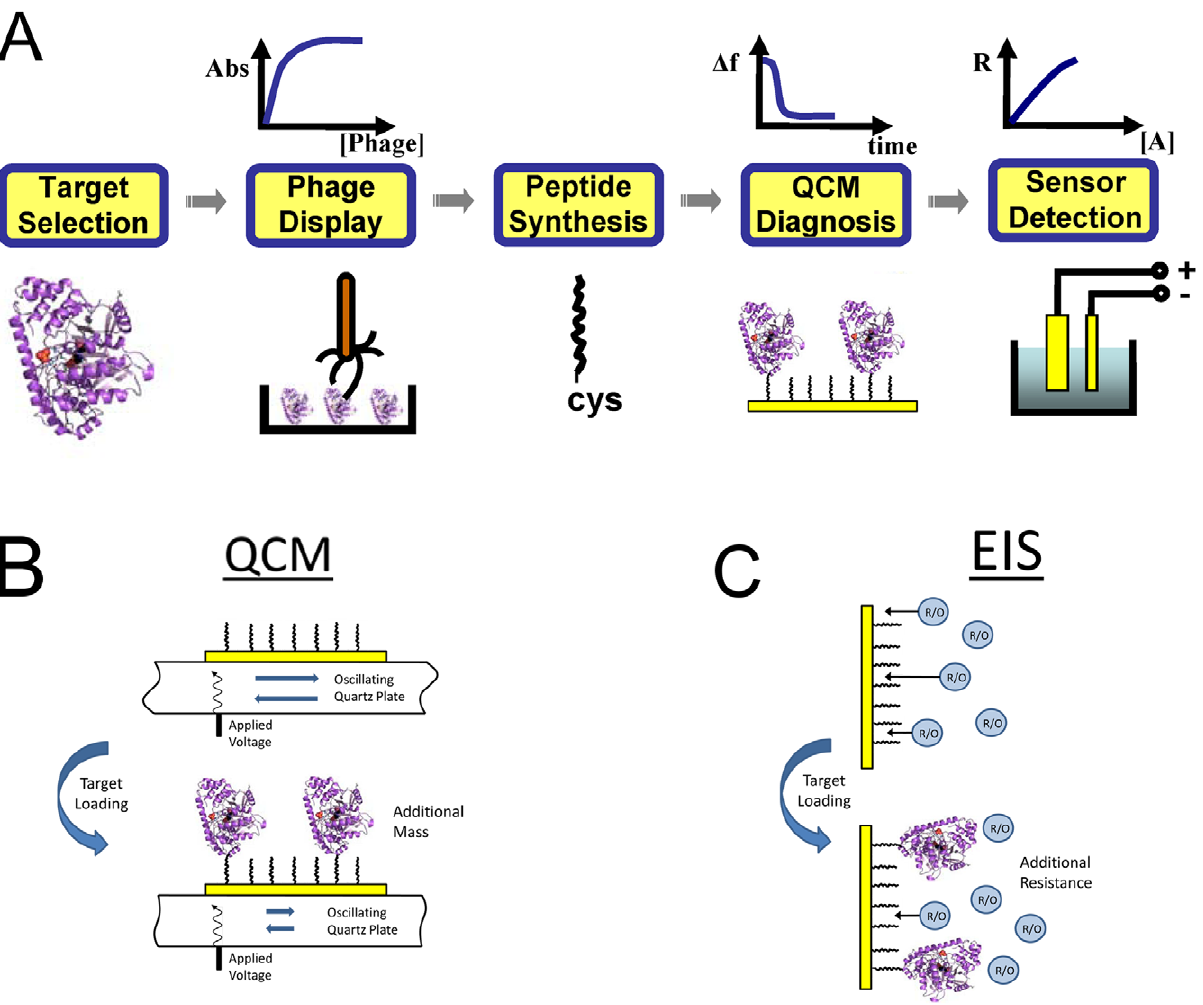
Figure 1. Schematic diagram illustrating the general process of biosensor development. (A) Work flow diagram for biosensor development: 1. Target protein selection, 2. Phage display selection, 3. Peptide synthesis, 4. QCM diagnosis, 5. Biosensor detection. B) The basic principle of QCM where the binding of the target protein to the immobilized peptides causes a frequency change in the oscillation of the quartz crystal. C) The basic principle of EIS where the binding of the target protein to the immobilized peptides causes increased resistance to the reaction of an added redox couple. See text for details.